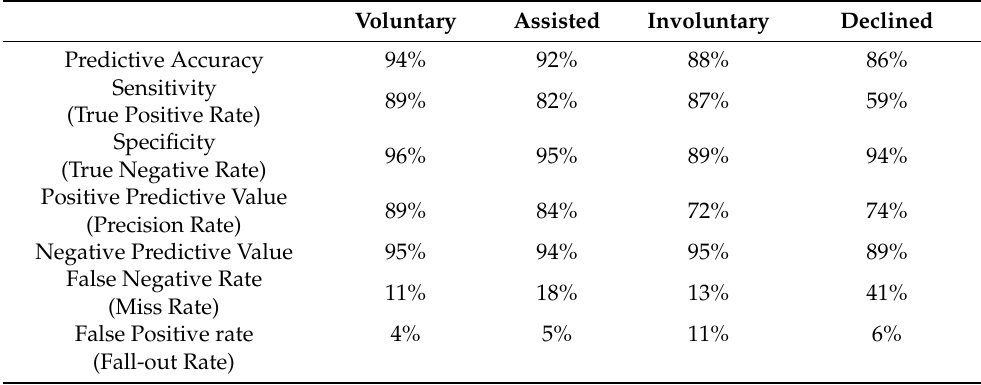
Table 4. Predictive validity calculations.